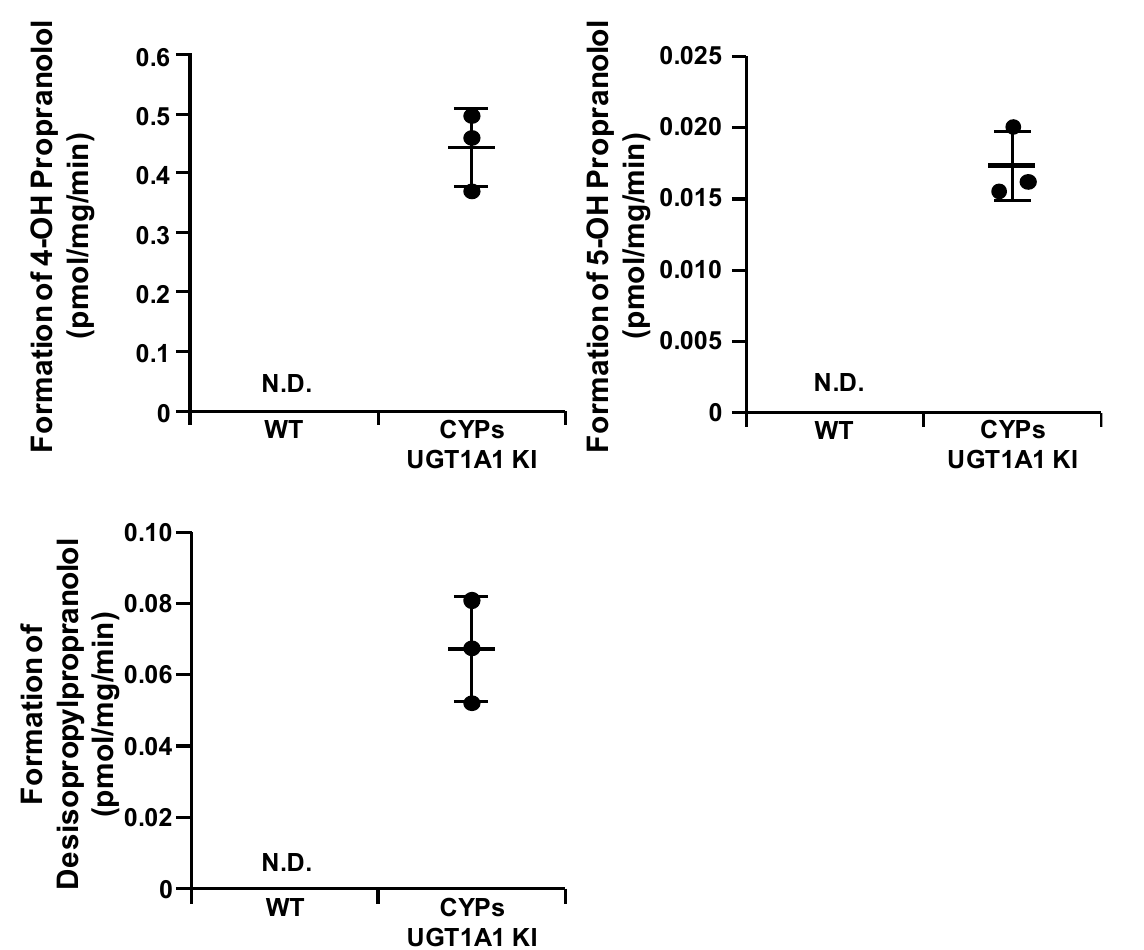
Figure 5. Major metabolites of propranolol formed by the CYPs–UGT1A1 KI-HepG2 cells. The CYP1A2 and CYP2D6 activities in the WT-HepG2 cells and the CYPs–UGT1A1 KI-HepG2 cells were evaluated by quantifying the metabolites of 1 µ M propranolol. The quantity of major metabolites (4 ′ -hydroxy propranolol, 5 ′ -hydroxy propranolol, and desisopropylpropranolol: metabolites for CYP2D6, 2D6, and 1A2, respectively) were measured by HPLC. Data are means ± SD of three technical replicates. N.D., not detected.